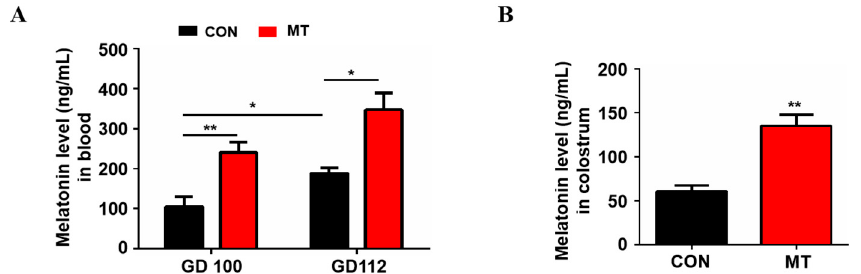
Figure 1. Melatonin level in blood and colostrum. ( A ) Blood melatonin levels at day 100 and 112 of gestation, respectively ( n = 4 for per group). ( B ) Melatonin level in colostrum ( n = 3 for per group). Data are presented as means ± SEM. * means p < 0.05. ** means p < 0.01. GD 100 = gestation day of 100, GD 112 = gestation day of 112, CON = control, MT = melatonin.